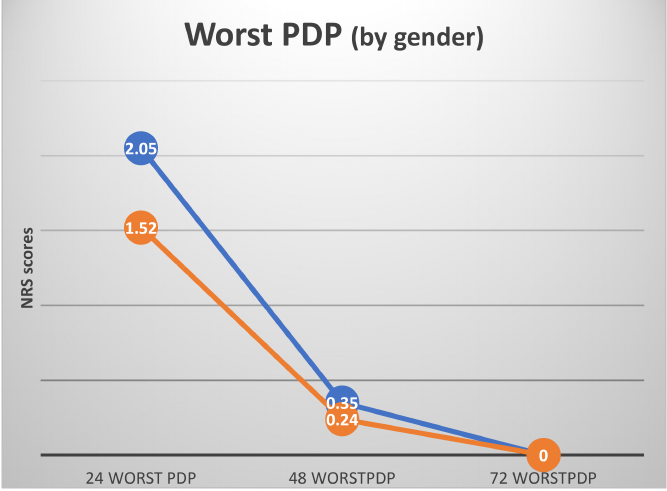
Figure 5. Worst PDP by gender, with dental anxiety (DAS) as a covariate (mean NRS scores with DAS as a covariate). Covariate appearing in the model evaluated at DAS = 8.8. Females—orange line, males—blue